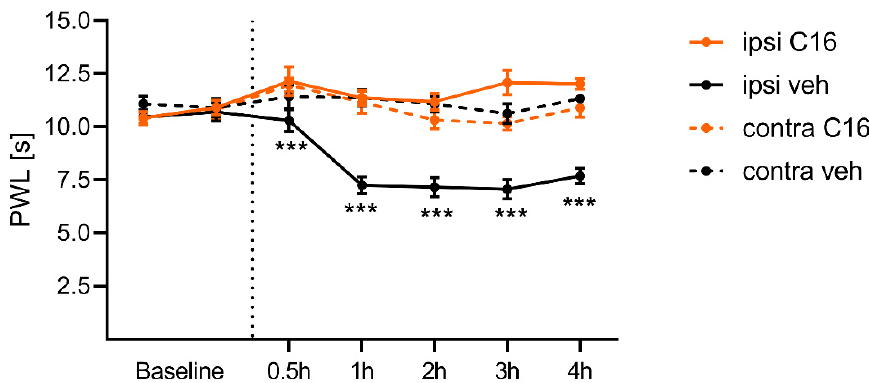
Figure 6. C16 dihydroceramide reduces the thermal hypersensitivity after capsaicin treatment in mice. We analyzed the baseline levels the day before and on the day of treatment. The mice were treated intraplantarly with either capsaicin and the C16 dihydroceramide or capsaicin and vehicle to analyze the analgesic properties of C16. The thermal pain threshold was assessed 30 min, 1 h, 2 h, 3 h, and 4 h after treatment. The data represent the mean ± SEM from seven mice per group., *** p < 0.001, as per two-way ANOVA with Bonferroni’s post-hoc test.